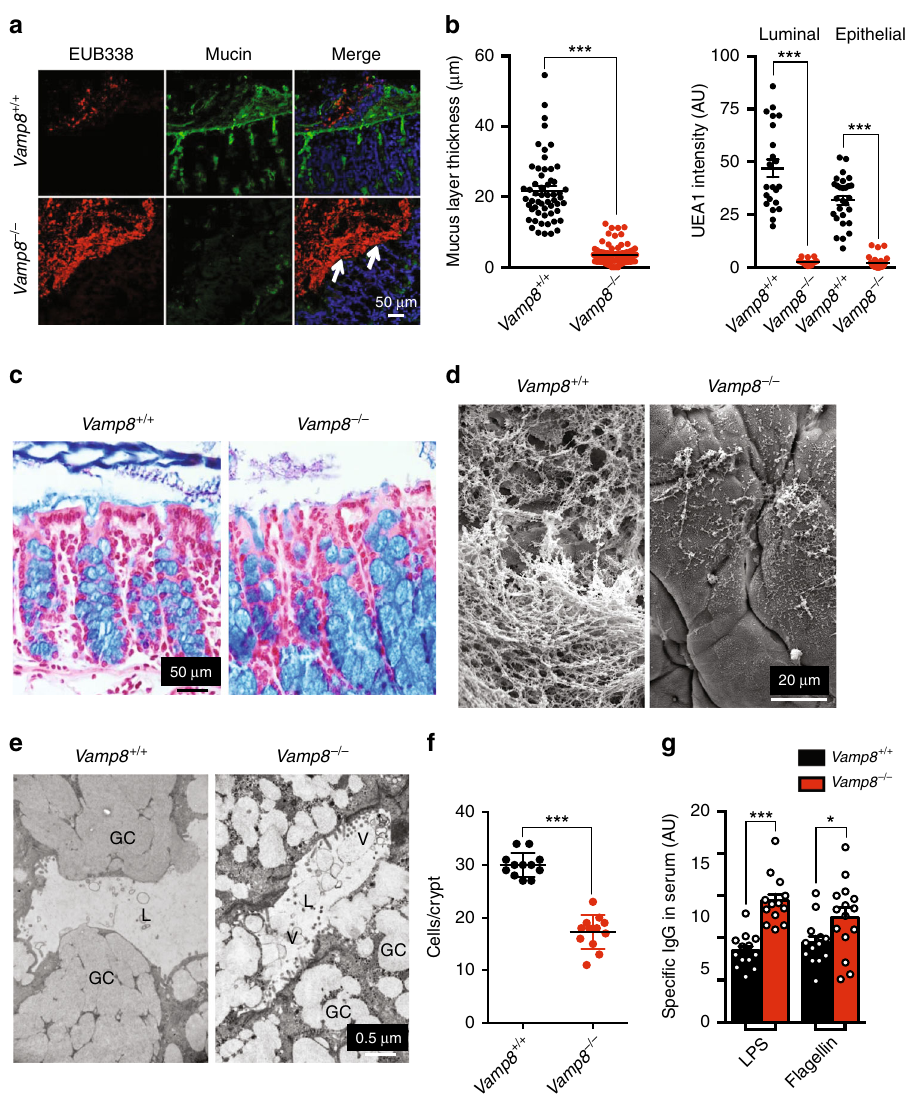
Fig. 2 Alterations to the mucosal barrier in Vamp8 − / − . a Commensal bacteria was visualized with the ubiquitous FISH probe EUB338 (red) and mucin with UEA1-Fucose lectin (green) on Carnoy ’ s fi xed colon tissues (four independent experiments, three mice per genotype; scale bar 50 μ m). Note the paucity of mucus in Vamp8 − / − with bacteria in contact with the surface epithelium (arrows). b The thickness of the mucus layer adjacent to the apical epithelial surface was measured on multiple ROIs as de fi ned from the distance from the apical surface to nearest detectable EUB338 + bacteria (pooled from four independent experiments, three mice per genotype, >4 ROIs per mouse). The intensity of UEA1 fucose in both the lumen and epithelial cell layer was assessed (six mice per genotype, >4 ROIs per mouse). c Colon sections were stained with Alcian blue to visualize secreted and mucin in goblet cells (three independent experiments, three mice per genotype, scale bar 50 μ m). d Scanning electron microscopy of the epithelial surface was performed on unwashed colon segments showing abundant mucin strands in Vamp8 + / + but not in Vamp8 − / − littermates (four independent experiments, two mice per genotype, scale bar 20 μ m). e Transmission electron microscopy was used to observe ultrastructure anomalies in goblet cells (GC) and mucin vesicles (V) in the lumen (L) of Vamp8 − / − (four independent experiments, two mice per genotype, scale bar 0.5 μ m). f The number of epithelial cells per crypt was quanti fi ed by counting histological specimens manually (three mice per genotype, >3 crypts per section). g Circulating IgG antibodies against LPS and Flagellin were quanti fi ed in the serum from Vamp8 + / + and Vamp8 − / − littermates by ELISA (pooled from three independent experiments, fi ve mice per genotype). Bars indicate mean ± standard error of the mean. * P < 0.05, *** P < 0.001 Unpaired two-tailed Student's T -test b , f , differentially expanded in the small intestinal lamina propria or however CD4 + T cells in Vamp8 − / − expressed similar levels in the periphery as assessed in the spleen (Fig. 5l, m). Treg (Supplementary Fig. 5D – F). Intriguingly, intestinal organoids that expansion and production of Il-10 was region speci fi c in the are sterile retained the tolerogenic phenotype producing Tgf- β 1 in intestine as no differential expression was observed in the small a STAT3-dependent manner (Fig. 5n, o). To test the importance intestine however, colonic CD4 + T cells in Vamp8 − / − produced of increased Tgf- β within the colonic epithelium in Vamp8 − / − on signi fi cantly more Il-10 (Supplementary Fig. 5A). Epithelial cells controlling Treg abundance and suppressing spontaneous and APC were not signi fi cantly different in expression of Il-10 in fl ammation in the context of increased microbial proximity, (Supplementary Fig. 5B, C). In contrast, differential Tgf- β 1 in vivo antibody neutralization with anti-TGFB (1D11) was expression was mostly observed in epithelial and APC cells, performed. Both Vamp8 + / + and Vamp8 − / − littermates were